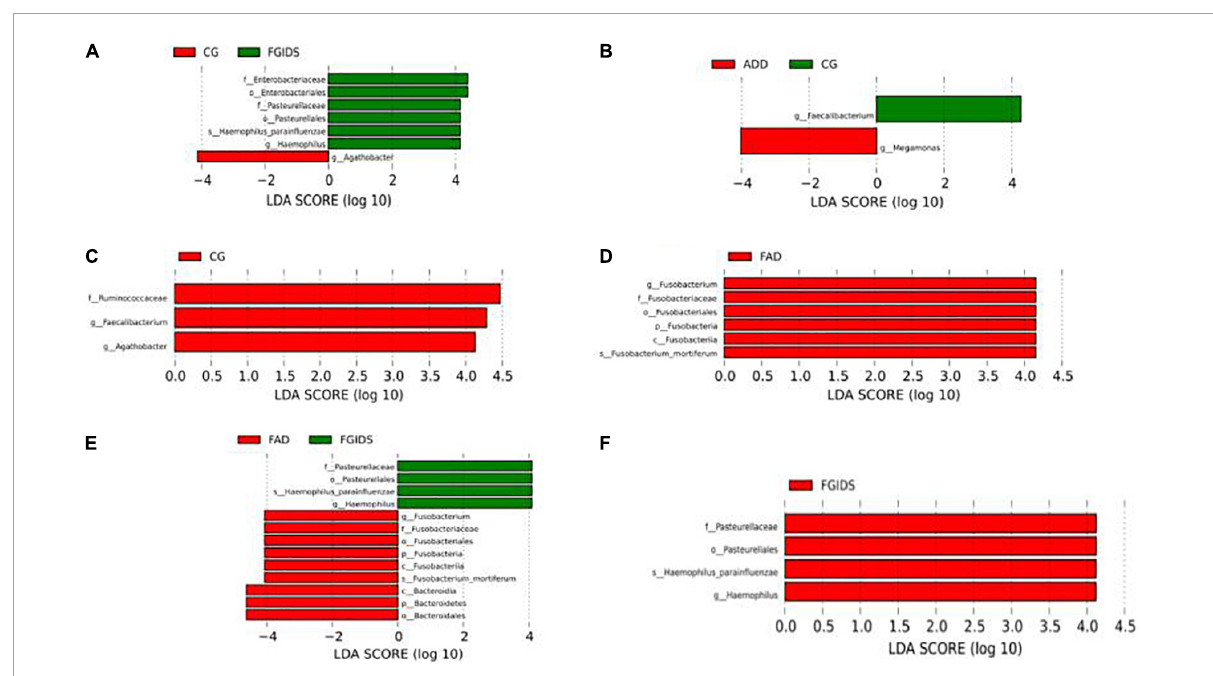
FIGURE5 Analysis of significant difference flora among different group. (A) CG-FGIDS. (B) ADD-CG. (C) FAD-CG. (D) ADD-FAD. (E) ADD-FGIDS. (F) FAD-FGIDS.